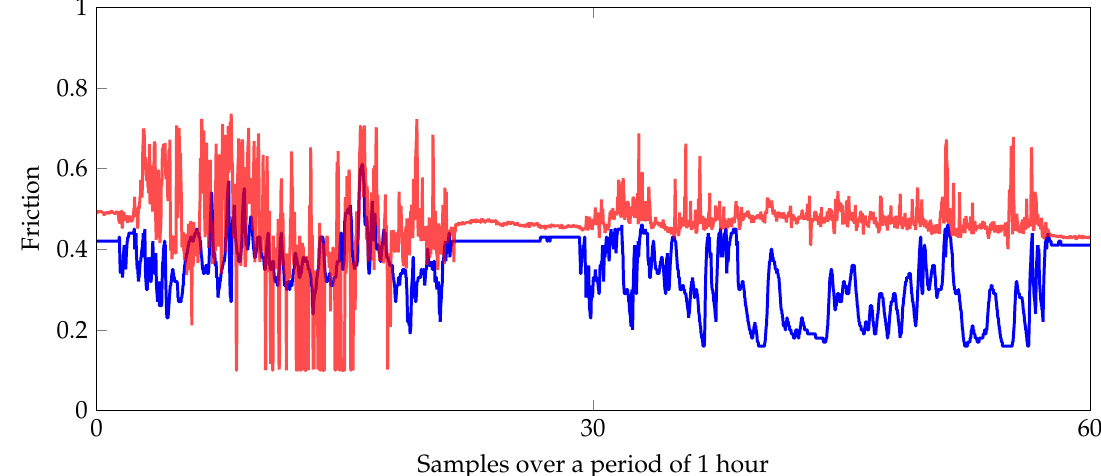
Figure 7. The plots of friction data from RCM411 in blue and MARWIS in red, during a 1 h